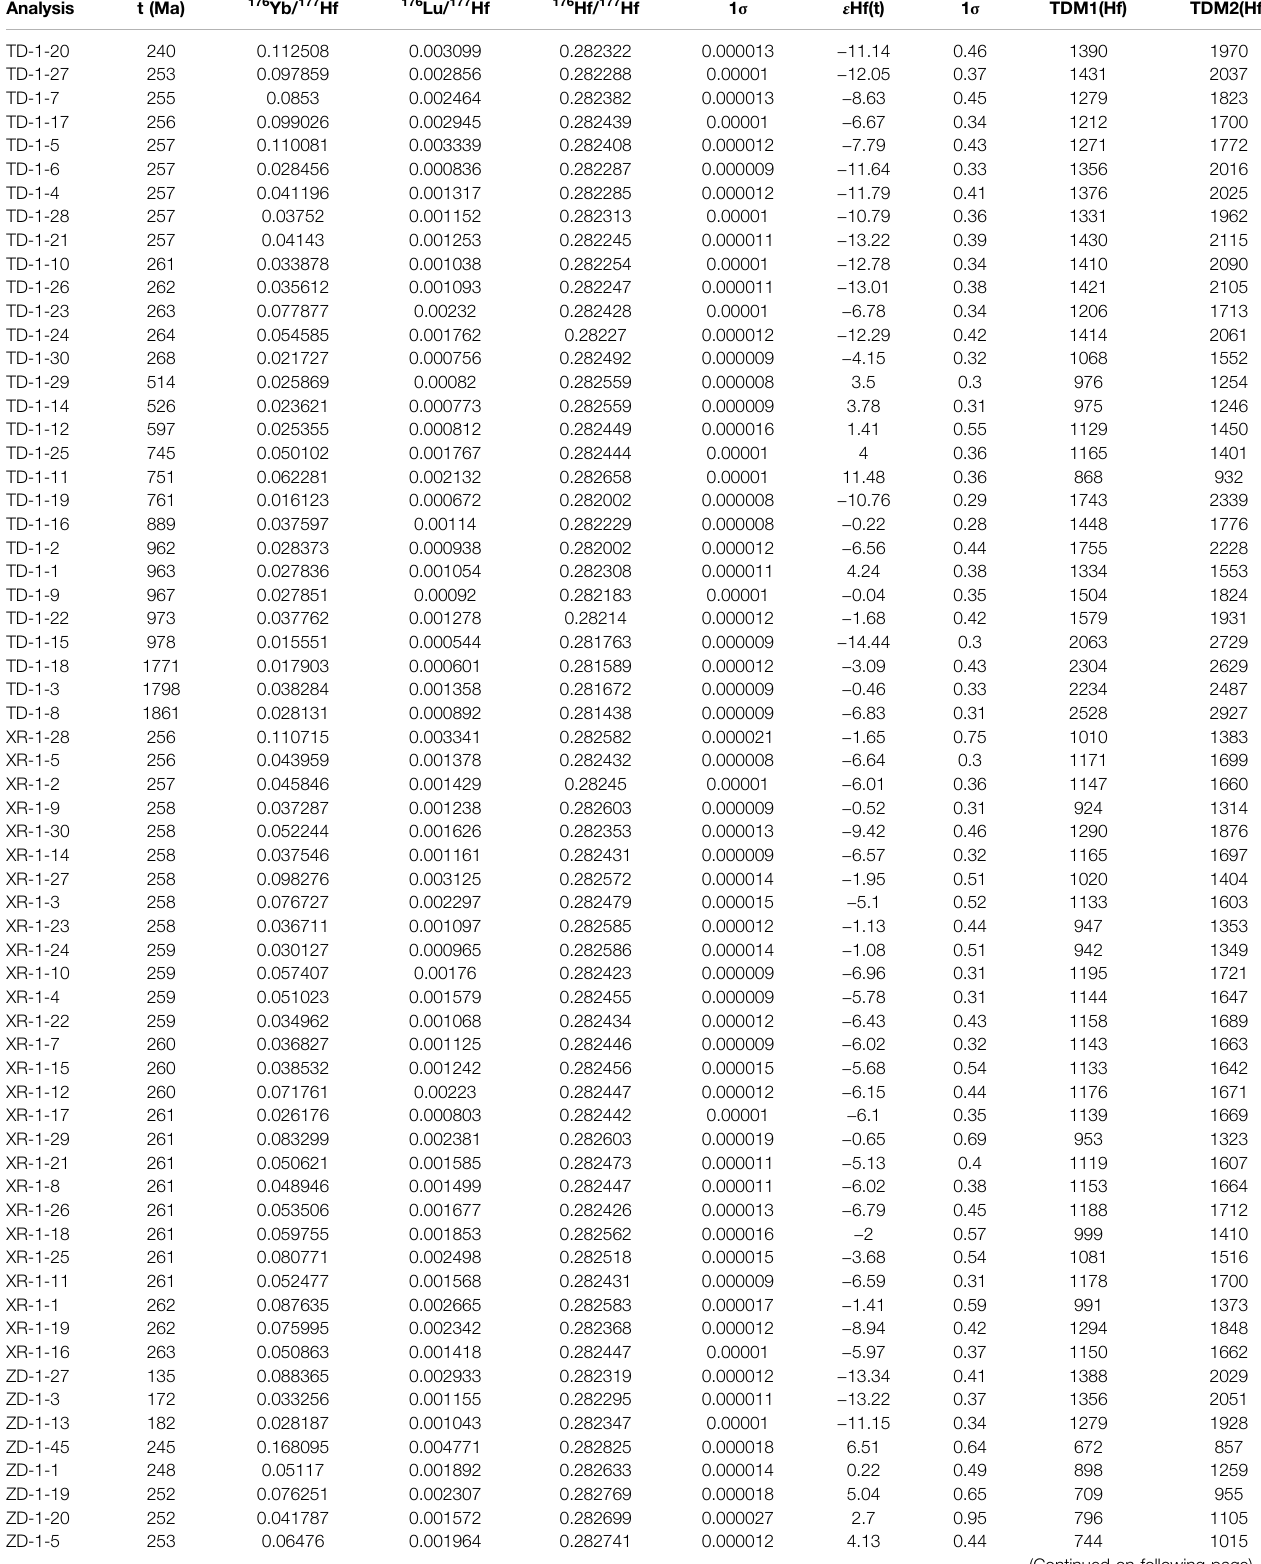
TABLE 3 | Zircon Hf isotopic data for the Longlin basalt